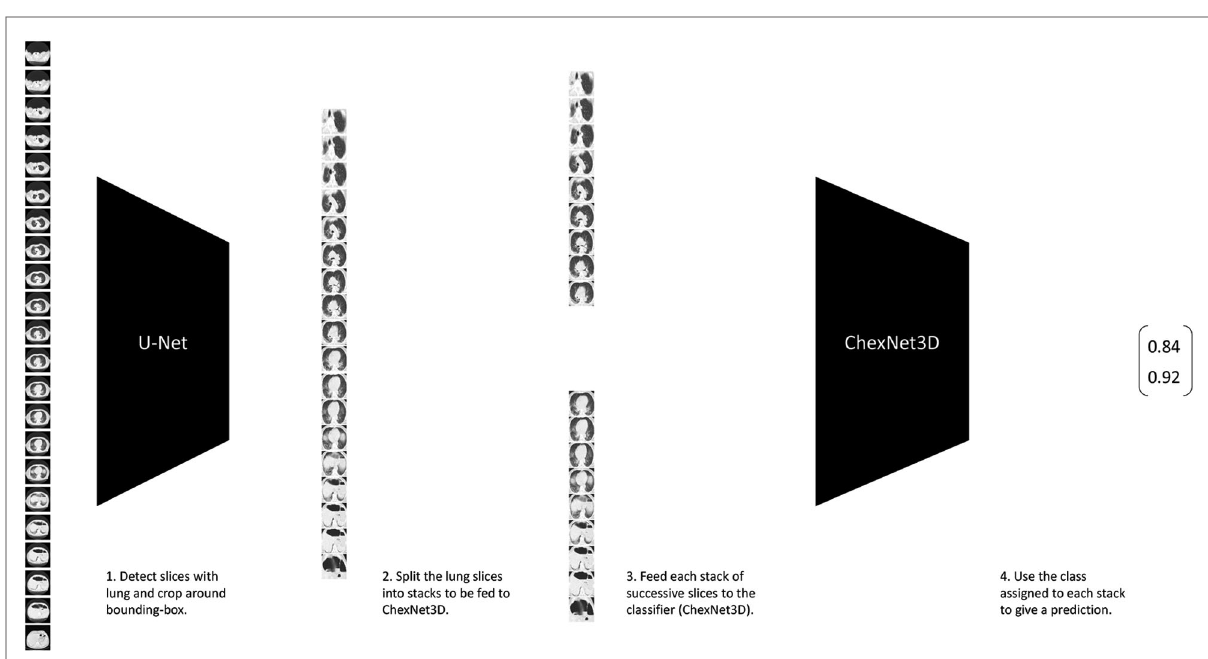
FIGURE 2 Lung CT classi fi cation pipeline. It takes stacks of n successive slices from the CT volume, and inputs them to the proposed ChexNet3D. Before that, the study is fed to U-Net to select the slices that contain lung portions and segment around the lung ’ s bounding